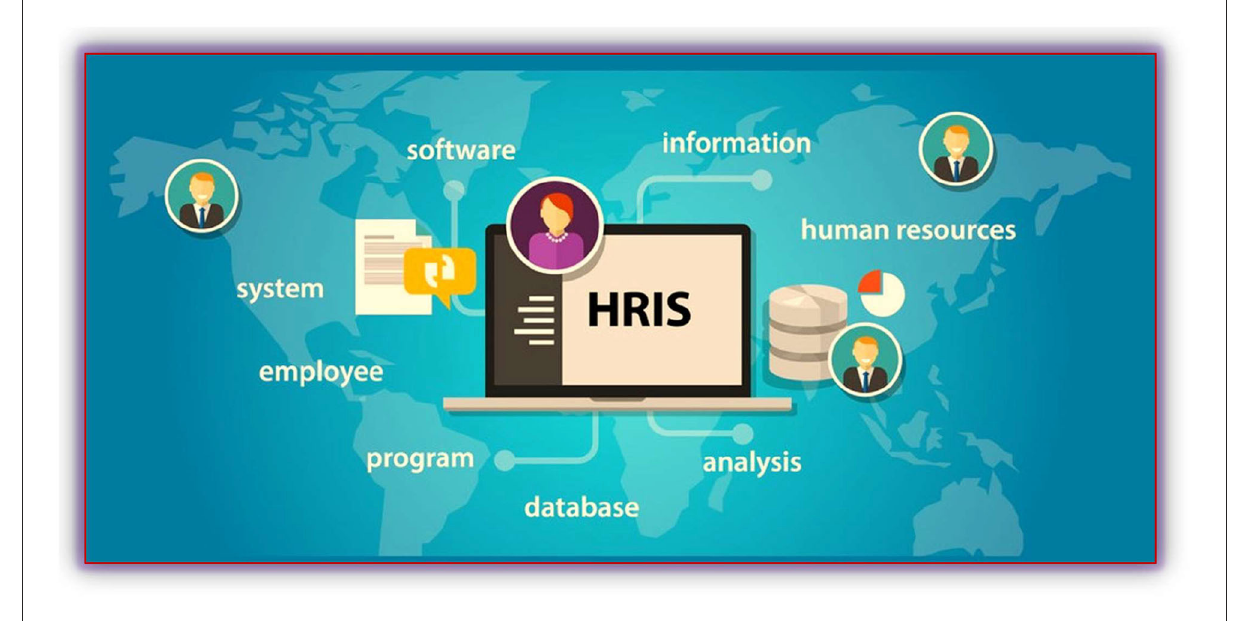
FIGURE6 Components of HRIS (source: authors, based on Ball, 2001; Markova, 2012; Kazmi and Naaranoja,